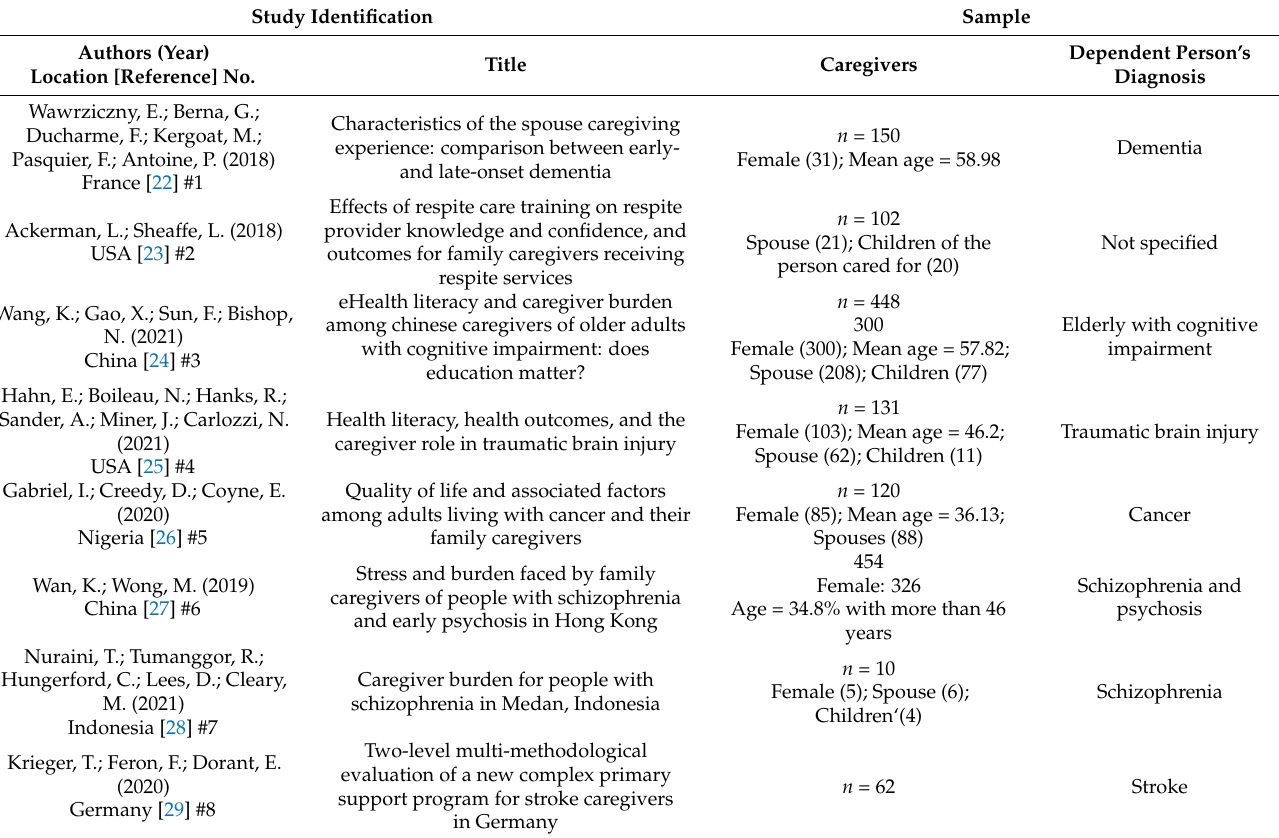
Table 1. Identification and characteristics of the samples used in selected